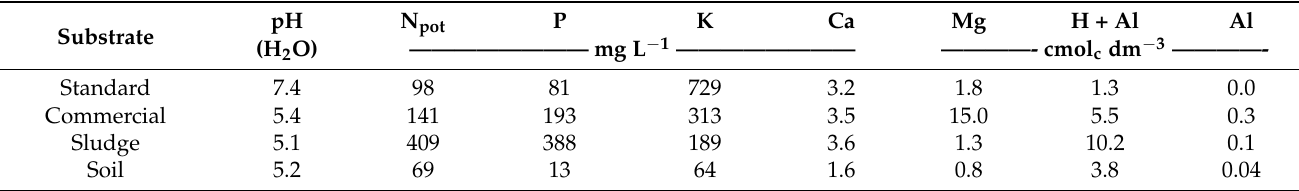
Table 3. Chemical fertility (methodology in [30]) and pH of the substrates and components used to produce Samanea saman seedlings with different substrates and inoculation patterns.